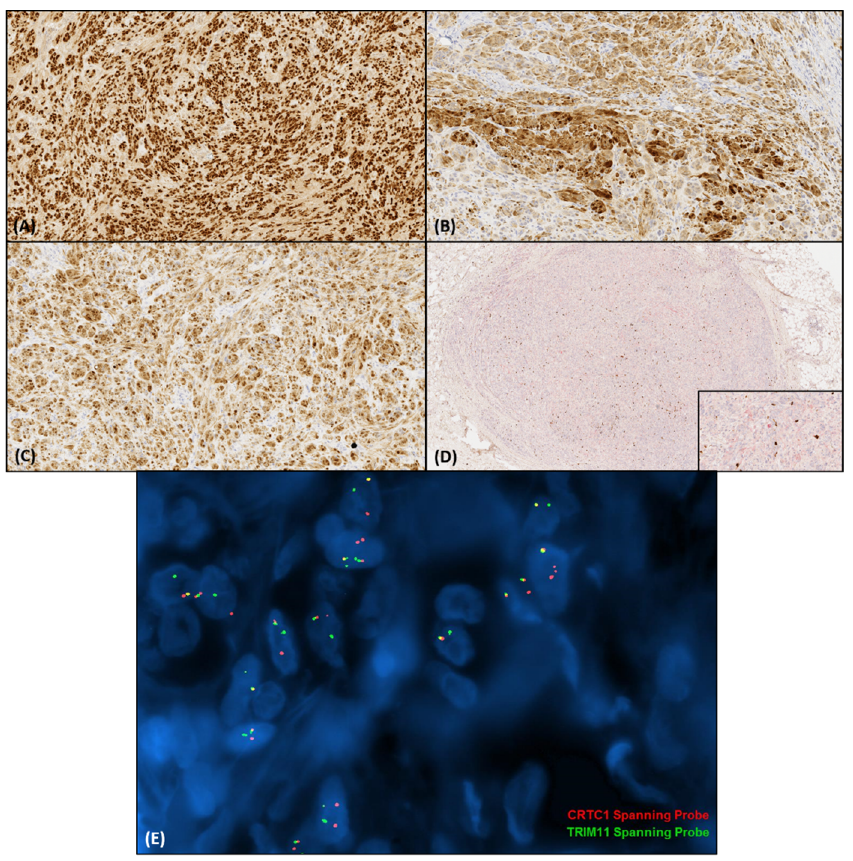
Figure 2. Immunohistochemical features of CMTCT. ( A ). SOX10 shows diffuse nuclear immunoreaction (140×). ( B ). S100-protein shows nuclear and cytoplasmic positivity (140×). ( C ). MITF is also diffusely positive (140×). ( D ). The double staining of MelanA and Ki-67 shows a low proliferation index (20×) and focal weak MelanA immunoreaction (inset, 100×). ( E ). Fluorescence in situ hybridization revealed the juxtaposition of the red ( CRTC1 ) and green ( TRIM11 ) signals. (Study kindly performed by Julia A. Bridge, University of Nebraska Medical Center).